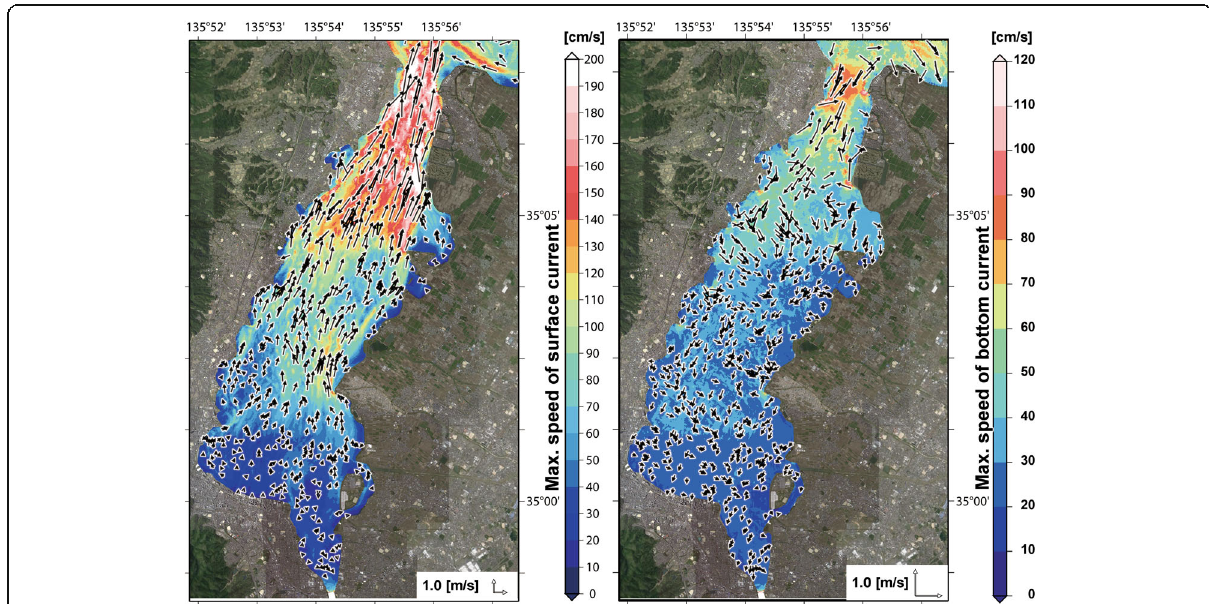
Fig. 12 Maps of the maximum velocity fields (vectors) and speeds (colors) for the surface (left) and bottom (right) currents simulated by the FVCOM during the period of 14:00 – 19:00 JST on 4 September 2018 (Fig. 15). The spatial pattern of the time-averaged